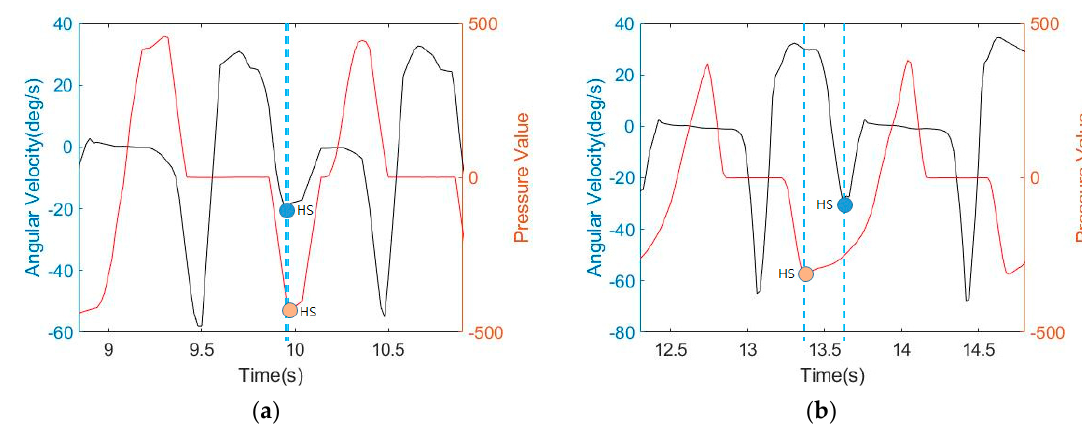
Figure 14. Comparison of gyroscope and pressure sensor data. ( a ) symmetric gait; and ( b ) asymmetric gait.